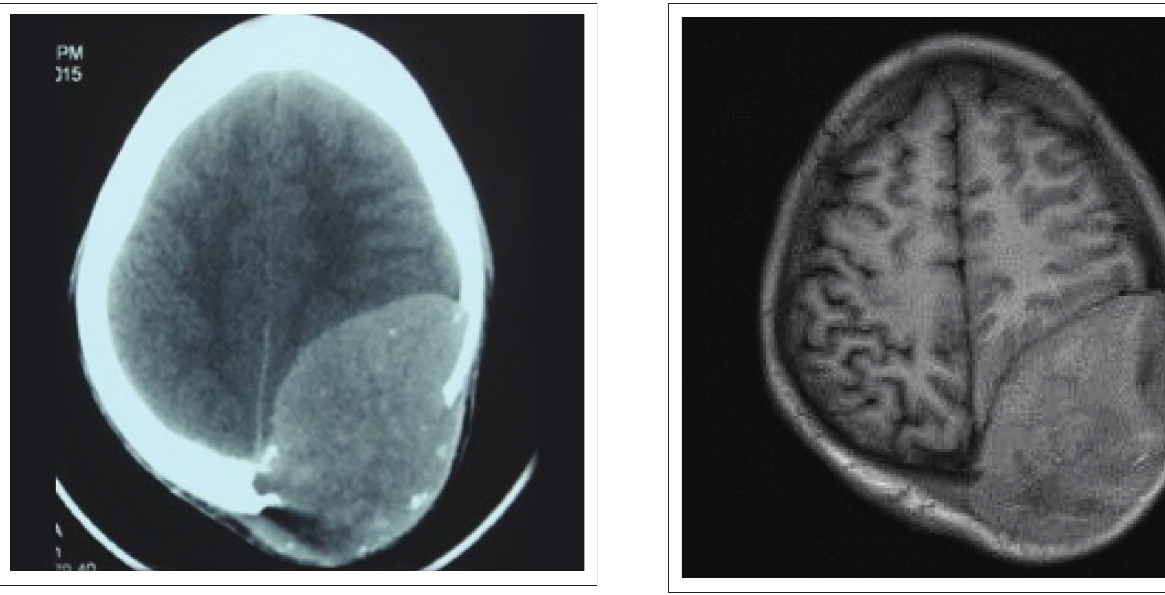
FIGURE 2: Non-enhanced CT scan in axial plane shows a heterogeneous mass lesion in the left parietal bone causing bone destruction with compression of adjacent brain parenchyma and extension into the scalp.